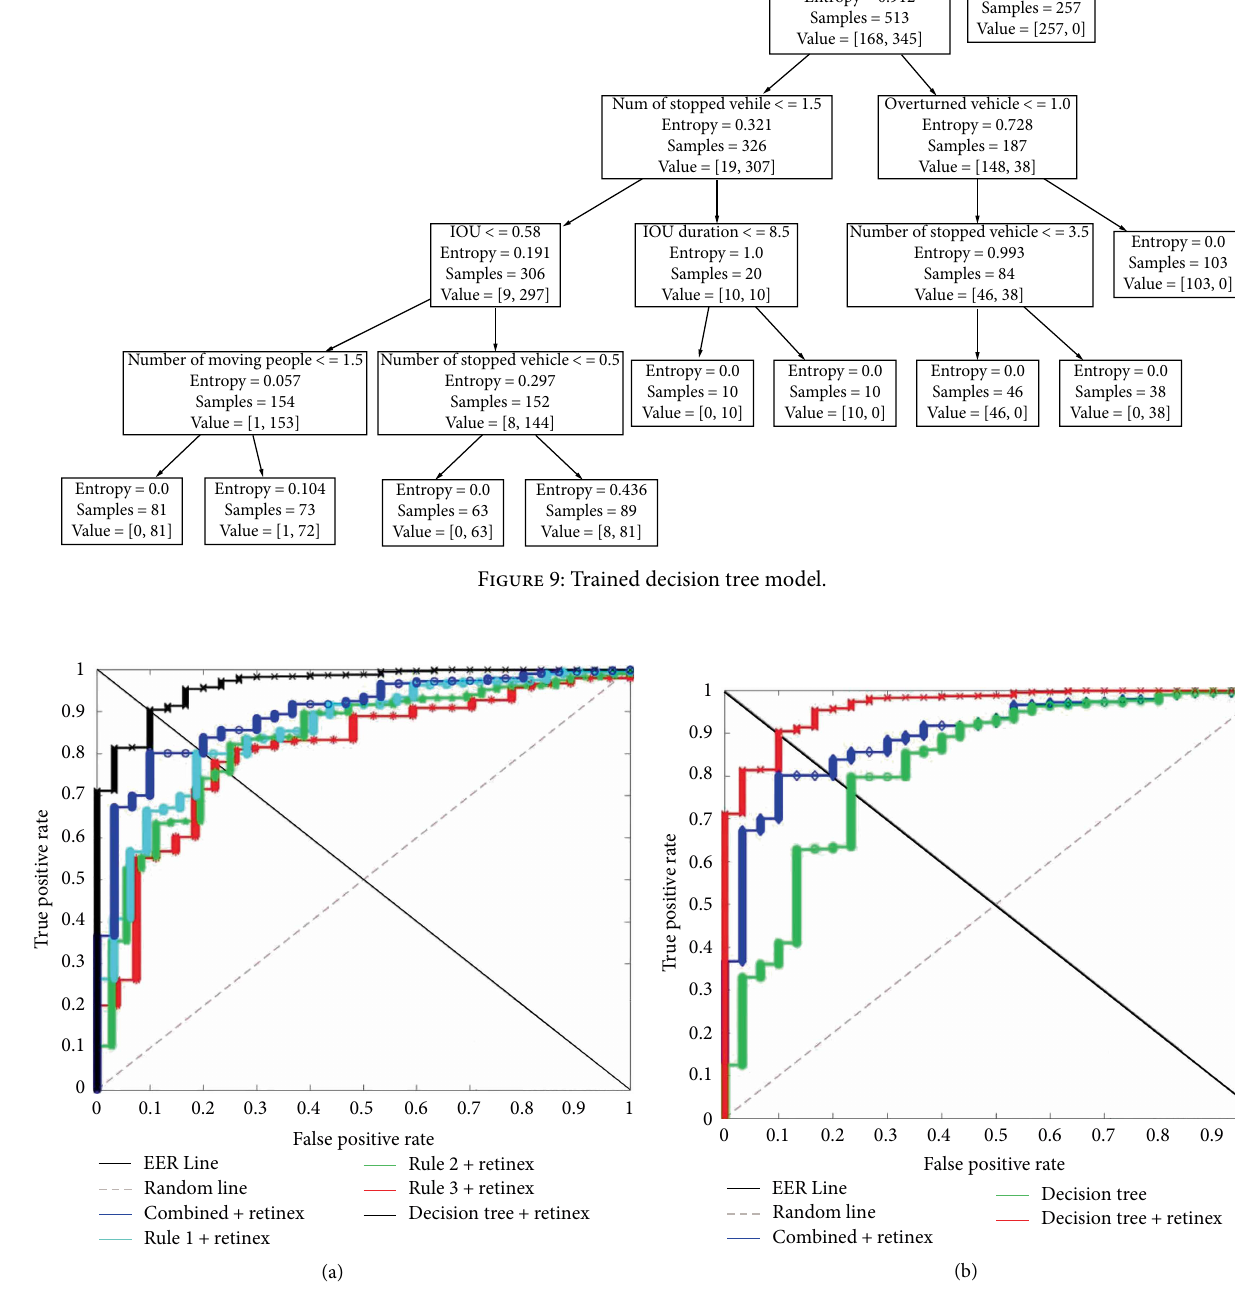
Figure 10: AUC comparison among multiple crash detection models. (a) AUC comparison among decision tree, combined-rule and single- rule detection models. (b) AUC comparison between crash detection models with/without Retinex